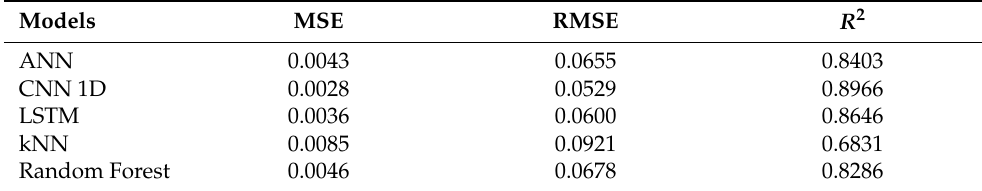
Table 6. Model performance